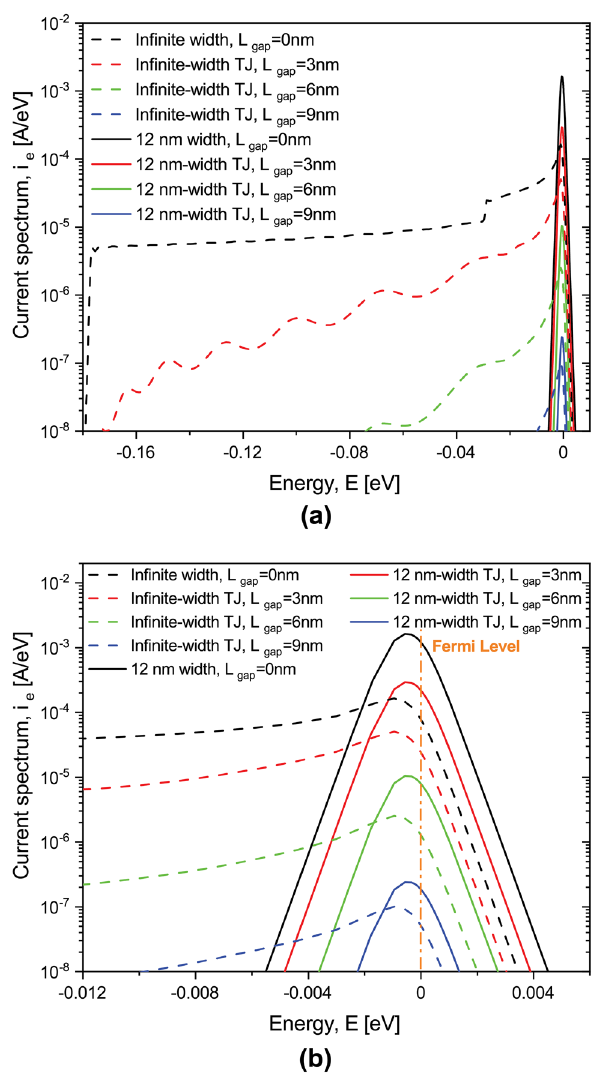
Figure 6. Current spectrum for Si:P δ -layer systems. ( a ) Comparison of the current spectrum i e (logarithmic scale) for an applied voltage of 1.0 mV between infinite and 12 nm-width δ -layer devices. ( b ) Close-up of the current spectrum within the Fermi level. The currents for the infinite-width δ -layer systems are normalized to a 12 nm for comparison purpose. N width of the device of W = 1.0 t =